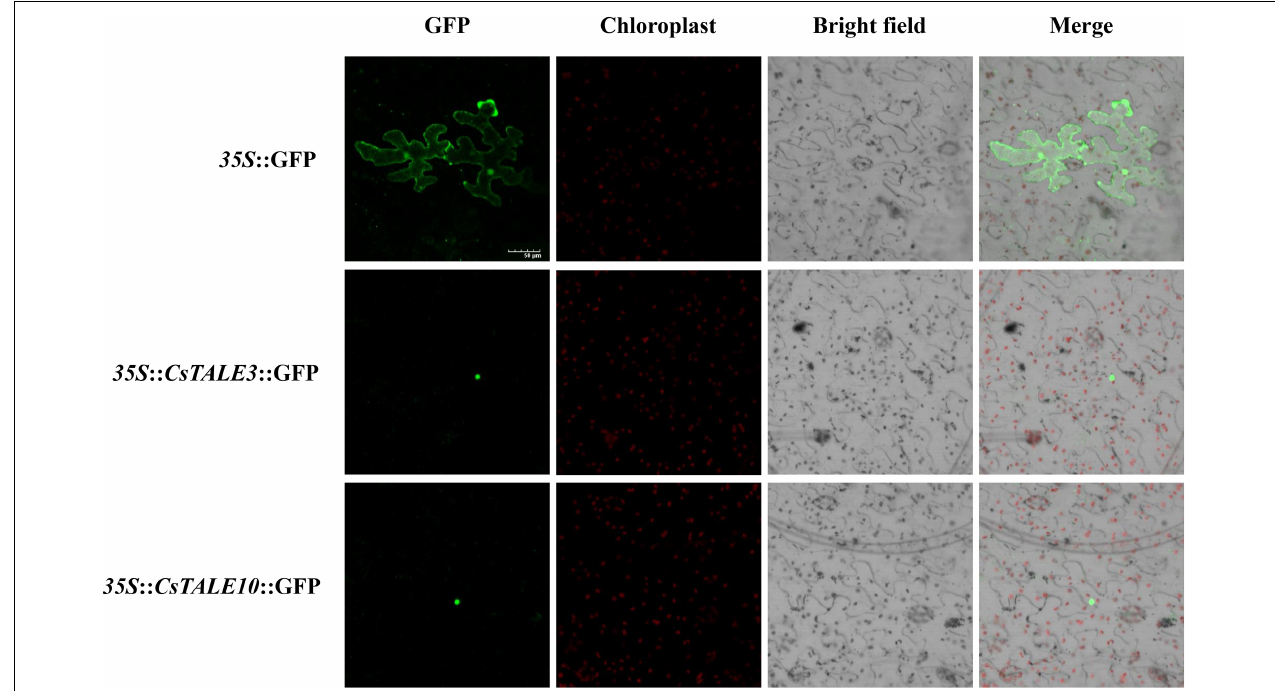
FIGURE 6 | Subcellular localization of CsTALE. The fusion constructs (35S:TALE-GFP) and GFP (control) were separately transiently expressed in tobacco leaves and visualized under a confocal laser scanning microscopy. Bar denotes 50 µ m.